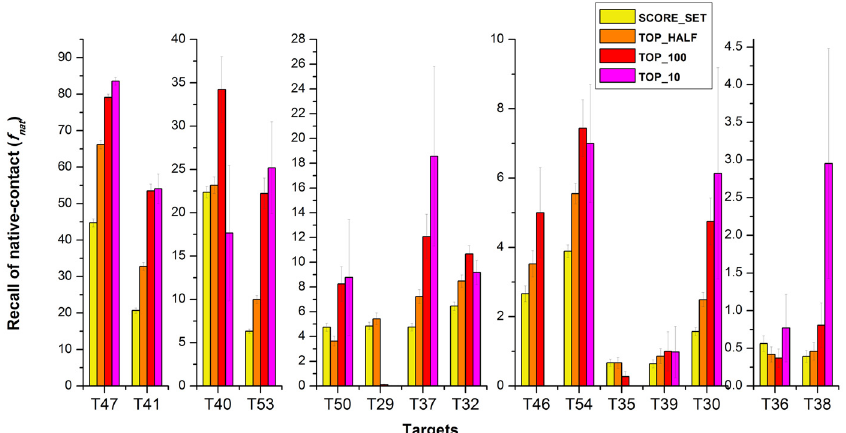
Fig 4. Enrichment of native-contacts between Score_set and our method. Four bars for each target represent the Recall in Score_set, Top_half, Top_100 and Top_10, respectively (left to right). For most of the Targets, Top_10 obtains the best Recall. The ordering of the targets is the same as in Fig 3. (hardest on the right). Note that for improved readability, the vertical scale decreases from left to